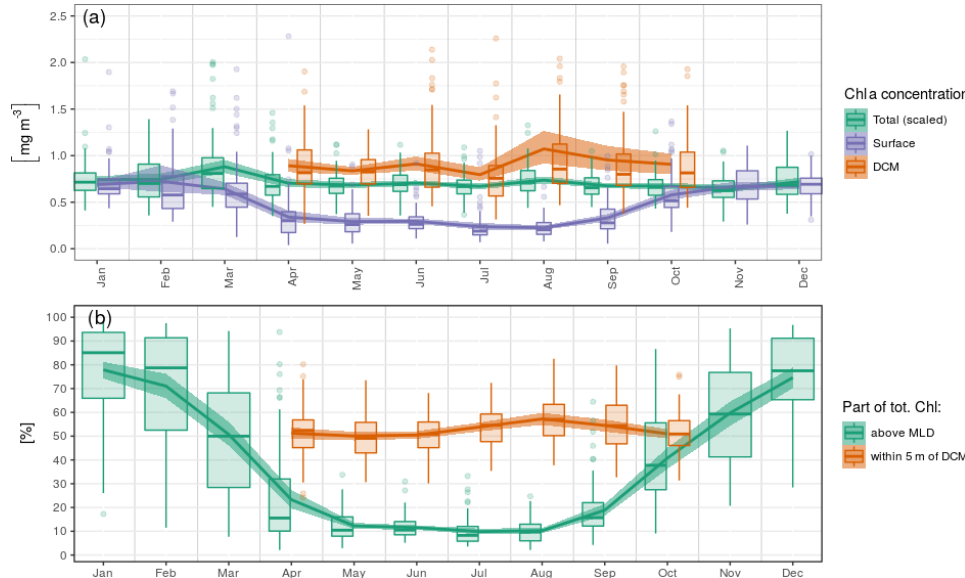
Figure 6. Seasonal variations in (a) surface, DCM and total chl a concentrations and (b) relative parts of the total chl a content around specific horizons. The total chl a concentration in (a) is the vertical integral of chl a concentration scaled by a constant depth of 40m to reach the unit of volumetric concentrations (mgm − 3 ).